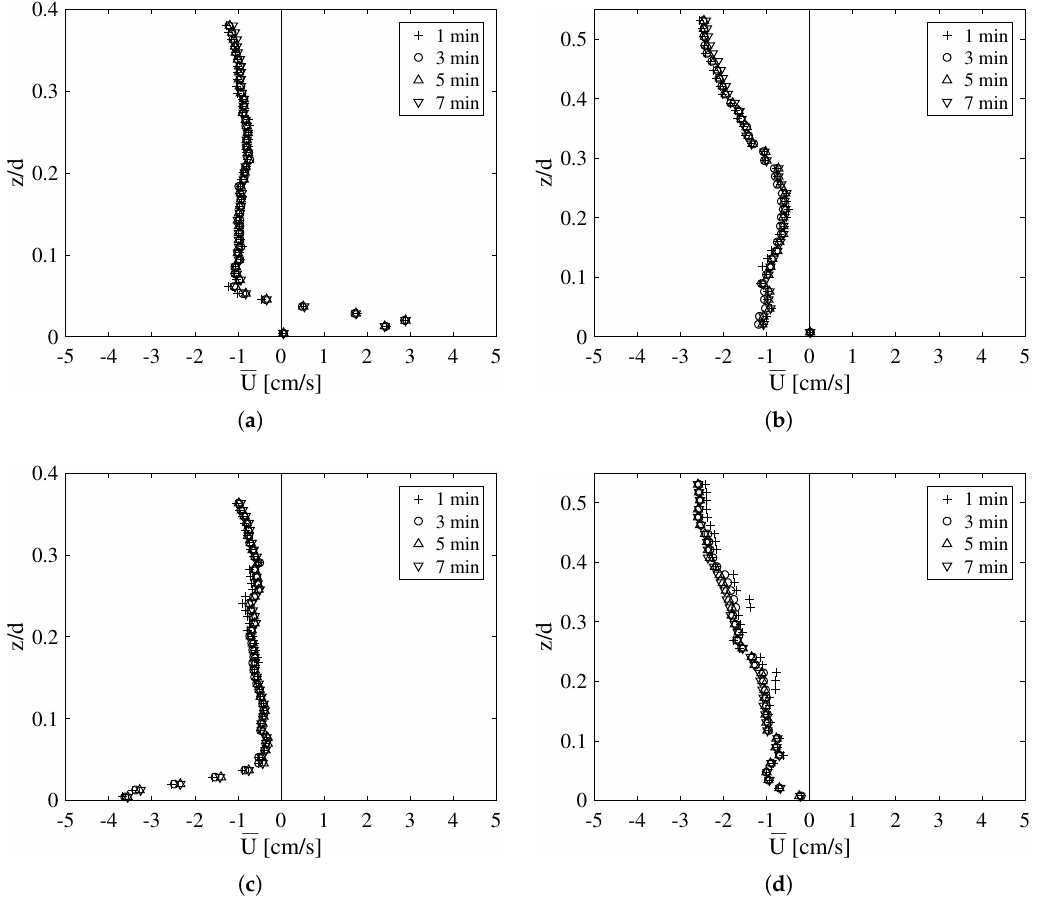
Figure 4. T 9 test ( H = 5.86 m, T = 1.26 s), period averaged U velocity profiles in the x